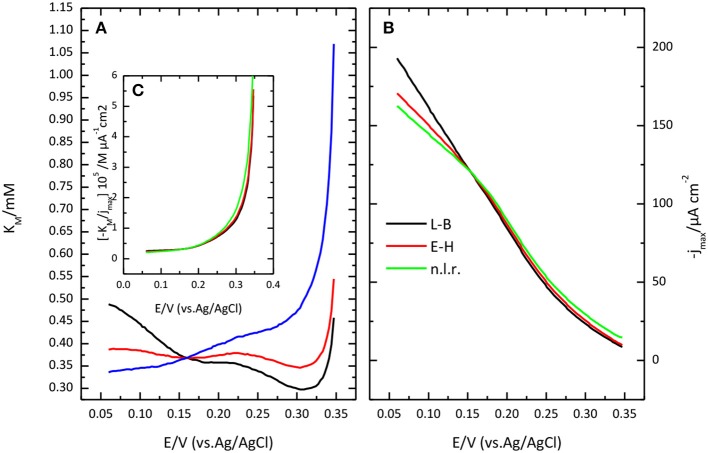
Potential dependence of Michaelis Menten parameters: K'M
(A) and jmax
(B) as obtained from Lineweaver-Burk plot (black lines), from Eadie-Hofstee (red lines) or from a nonlinear regression of the data (red lines). (C) plot of the ratio between K'M and jmax, as a function of potential.